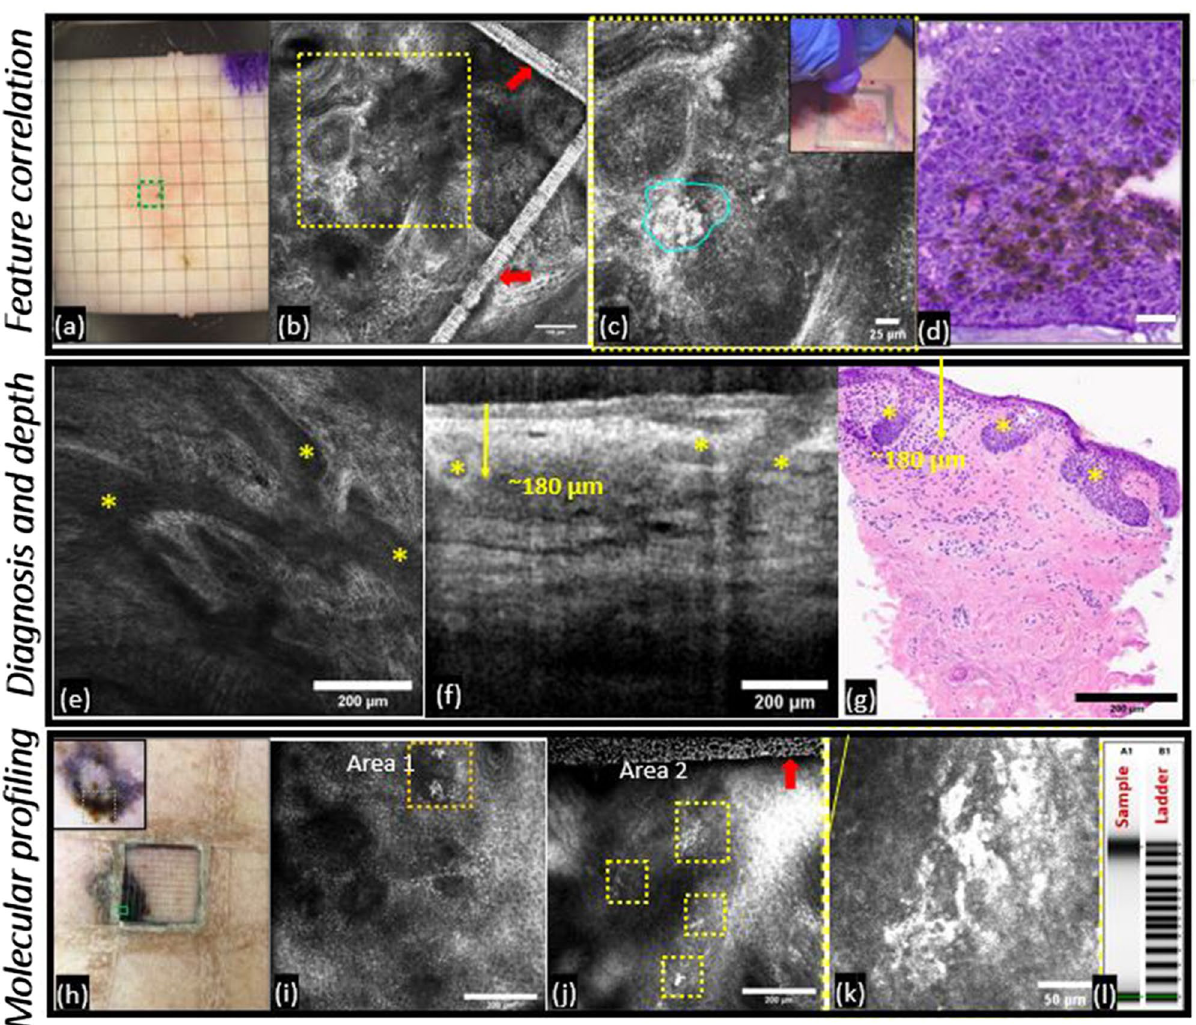
Figure 2. Targeted 1-mm biopsy enables diagnosis, feature and depth correlation, and molecular pathology. A. Diagnosis and Feature Correlation. ( a ) Clinical photograph after placing 1-mm grid on a suspected pigmented- BCC (green-box shows targeted-biopsy location following RCM), ( b ) RCM image shows tumor nests with bright cells inside and peripherally, confirming BCC diagnosis (metallic grid lines in RCM shown by red- arrows); ( c ) magnified view of the yellow-square shows bright cells (within cyan-hoops) inside and peripherally to tumor nests with inset photograph demonstrating 1-mm targeted-biopsy for RCM-histopathology correlation; ( d ) frozen histopathology (40x, scale bar = 25 µm) confirms bright cells as melanophages and melanocytes inside and peripheral to BCC nests. Depth correlation . ( e ) RCM imaging of suspected keratinocytic tumor revealed nests with peripheral palisading (yellow-asterisk) emanating from epidermis, confirming the diagnosis of BCC; ( f ) the same nests visualized in the superficial dermis on the spatially-registered OCT image with maximum depth measured to be ~ 180 µm; ( g ) precision biopsy followed by vertical sectioning confirmed the RCM-OCT diagnosis and depth. Molecular Pathology. ( h ) Clinical photograph of large invasive melanoma with metallic grid (green-box shows targeted-biopsy location following RCM) and dermoscopic photograph as inset (silver area in inset corresponds to grid placement); ( i ) Low density of melanoma cells (orange-boxes) inside tissue volume in area 1, ( j ) high density of melanoma cells (yellow-boxes) in area 2; ( k ) magnified RCM image highlighting the large atypical melanocytes in area 2; ( l ) Targeted 1-mm biopsy from area 2 yielded non- fragmented high-quality DNA (A1, sample) with DNA integrity number (DIN) value of 8.0 and total amount 680 ng which were successfully analyzed with IMPACT505-mutational profiling. These cases illustrate that high- resolution imaging-guided precision biopsy with 1-mm sampling allows correlation of the micron-level features and tumor depth with histopathology and yields adequate quantity and quality of DNA for molecular